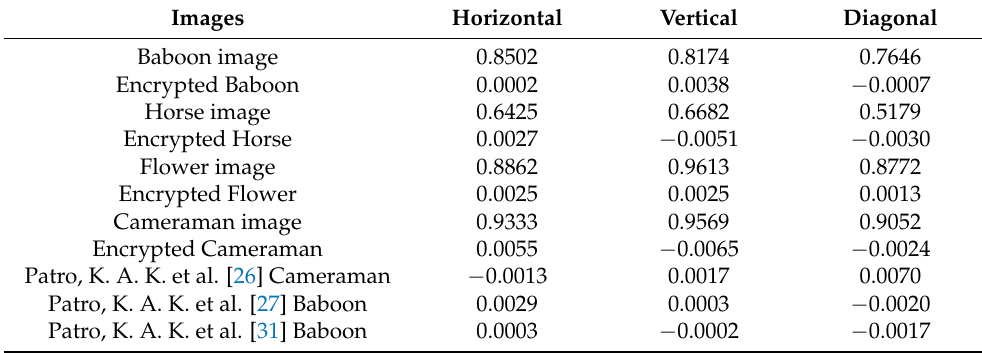
Table 5. Correlation coefficient